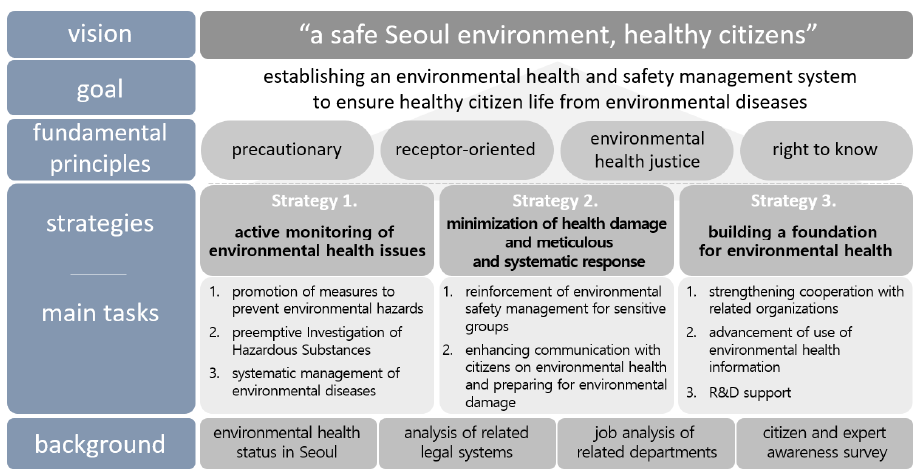
Figure 7. The basic direction of implementing the preliminary plan for environmental health in